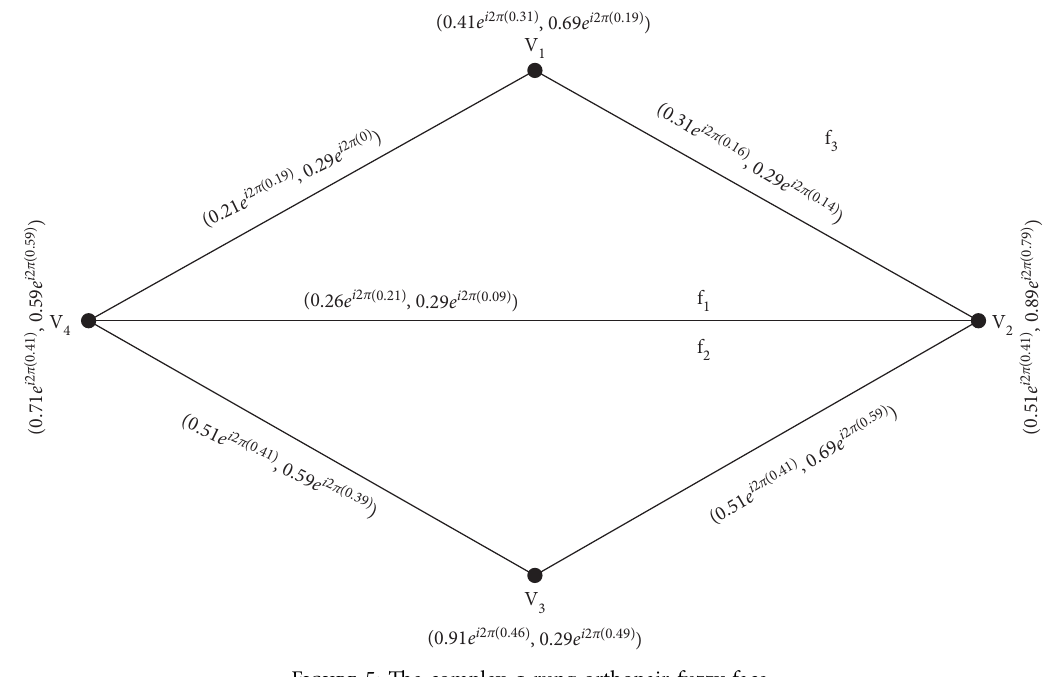
Figure 5: The complex q-rung orthopair fuzzy face.